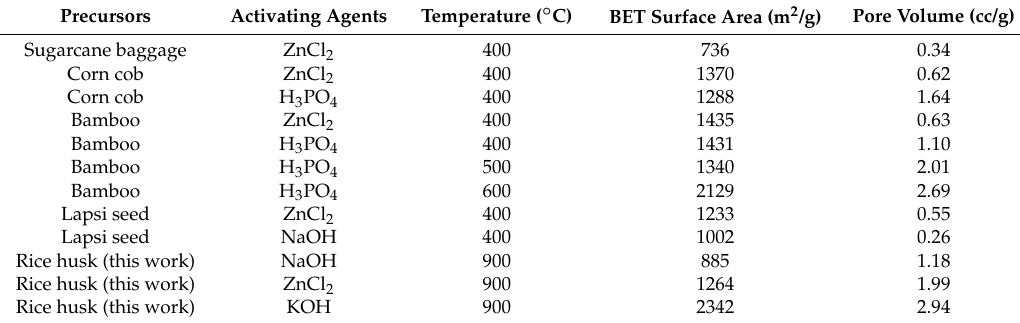
Table 1. Comparison of surface area and pore volume of our NCMs (derived from rice husk) with similar nanoporous carbon materials derived from other agro wastes by chemical activation method with different activating agents.